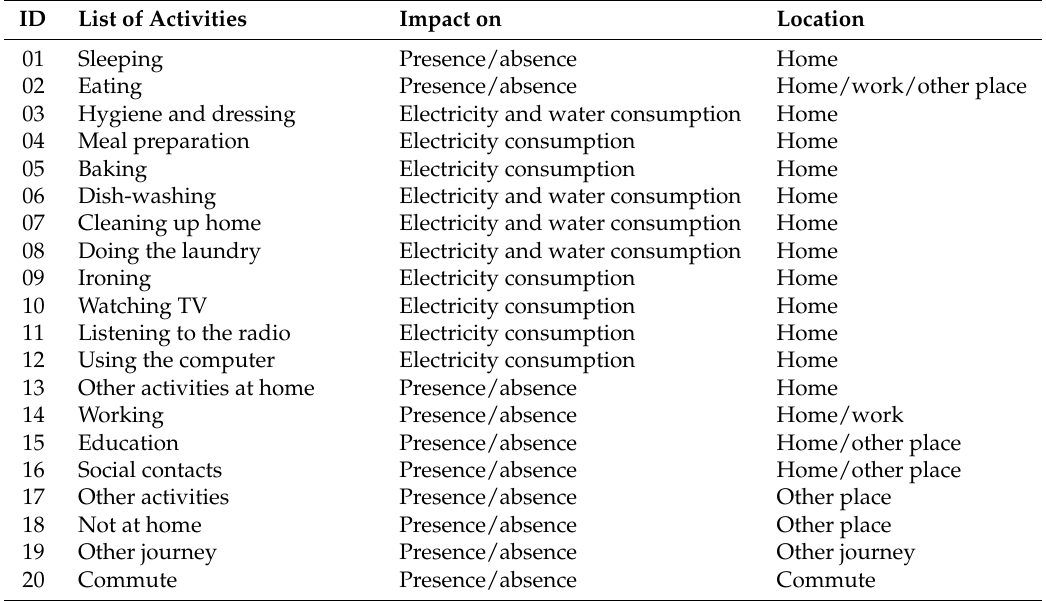
Table 2. Activity categories used in the